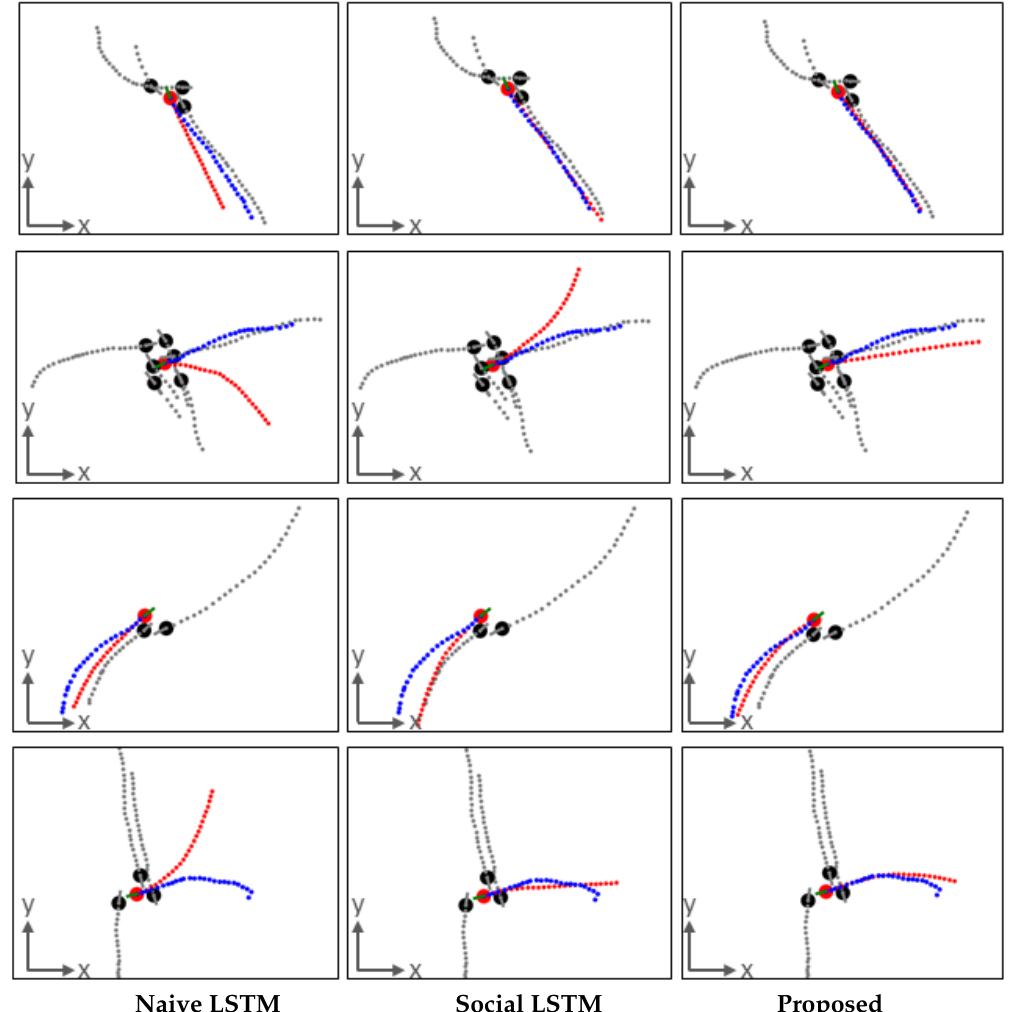
Figure 11. Four examples of trajectory prediction results from a 3.2 s observation to a 10.0 s prediction. Each row is an example. In every figure, each dot (red: agent, black: neighbors) is a pedestrian. For agent, green solid line: past trajectory, red dashed line: prediction, blue dashed line: ground truth. For neighbors, gray solid line: past trajectory, gray dashed line: following real trajectory. Results of Naive LSTM ( left ); results of Social LSTM ( middle ); results of proposed ( right